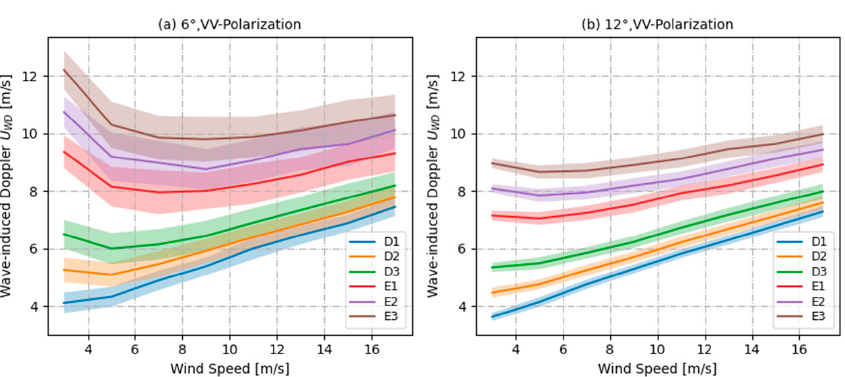
Figure 21. The variation in U WD and its standard deviation with wind speed when the swell scale is D1, D2, D3, E1, E2, and E3, where the colorful shading represents the data standard deviation.